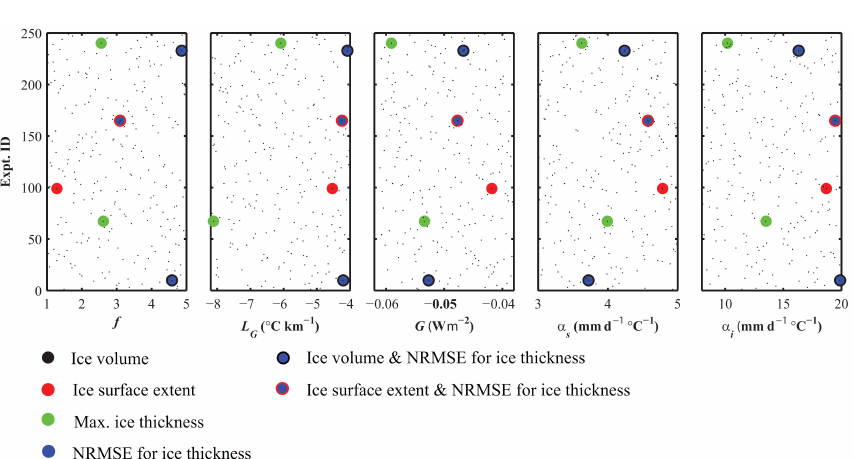
Figure 9. The distribution of each parameter for the six experiments selected according to ranking of the different diagnostics: ice volume, ice surface extent, maximum ice thickness and NRMSE of ice thickness. Experiment ID number is shown on the y-axis (from 1–250) with its corresponding parameter values on the x-axis. The small black dots represent all 250 experiments to show the parameter space covered.